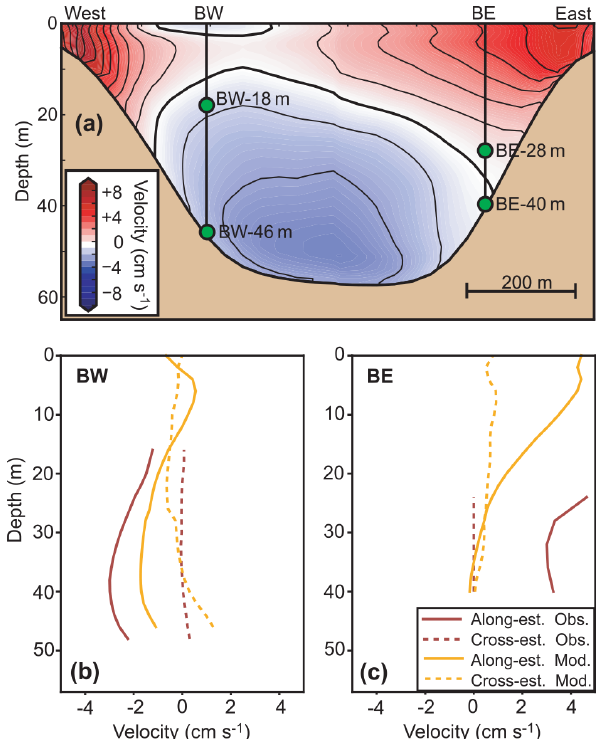
Figure 2. (a) The background colours show simulated northward velocity along the transect labelled ADCP in Fig. 1b averaged over the simulation period. The two vertical lines labelled BW and BE indicate the locations of two ADCPs moored on the bottom and green circles indicate the uppermost and lowermost depths with high-quality measurement for each of the ADCPs. (b, c) Velocity profiles along the strait (continuous curves, positive towards north) and across it (dashed curves, positive towards east) from the ADCP measurements (dark curves) and the model (light curves) at the two mooring sites averaged over the simulation